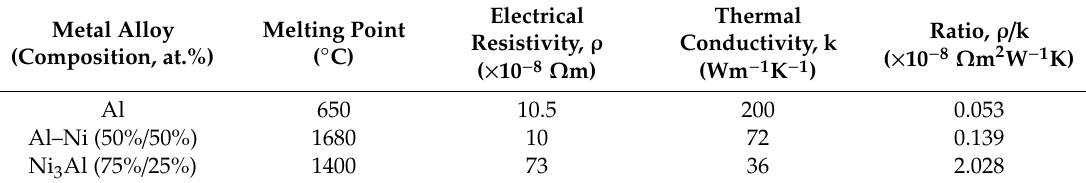
Table 2. Comparison between material properties of Al and relevant Al–Ni alloys [45–48]. Metal